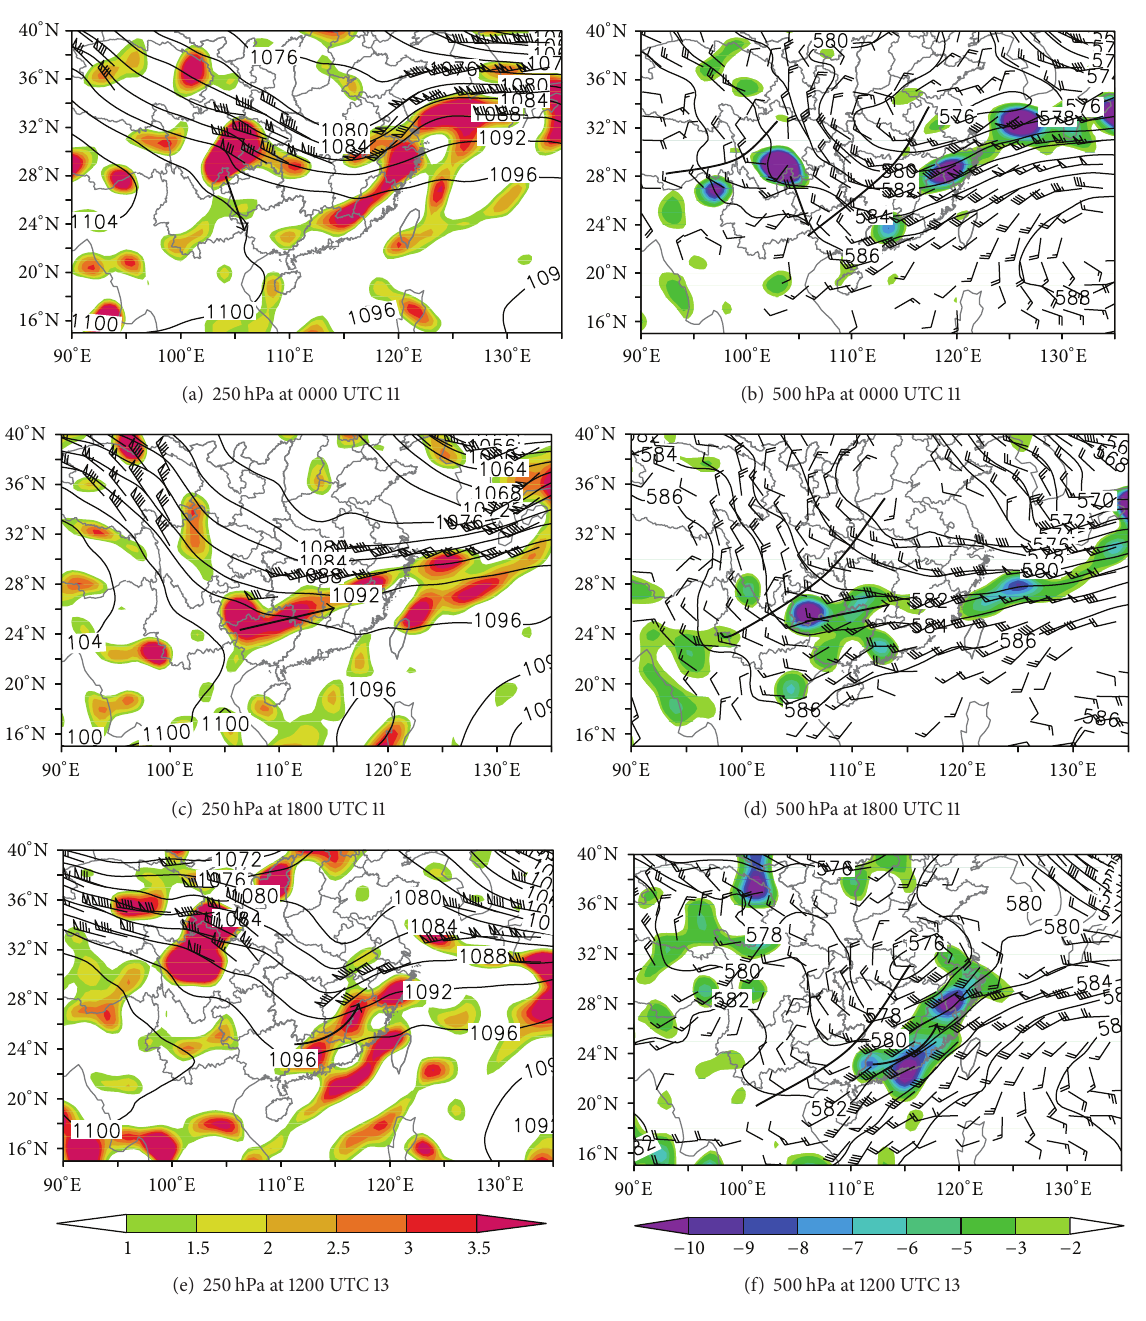
Figure 4: As in Figure 3, but at 250 hPa and 500 hPa with the dark lines standing for troughs and the arrow for the SWV motion direction.